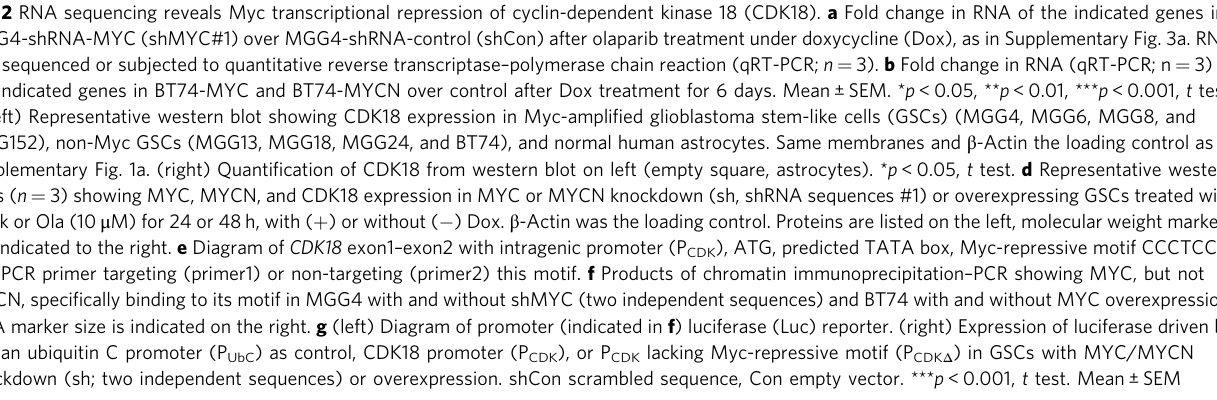
Fig. 2 RNA sequencing reveals Myc transcriptional repression of cyclin-dependent kinase 18 (CDK18). a Fold change in RNA of the indicated genes in MGG4-shRNA-MYC (shMYC#1) over MGG4-shRNA-control (shCon) after olaparib treatment under doxycycline (Dox), as in Supplementary Fig. 3a. RNA was sequenced or subjected to quantitative reverse transcriptase – polymerase chain reaction (qRT-PCR; n = 3). b Fold change in RNA (qRT-PCR; n = 3) of the indicated genes in BT74-MYC and BT74-MYCN over control after Dox treatment for 6 days. Mean ± SEM. * p < 0.05, ** p < 0.01, *** p < 0.001, t test. c (left) Representative western blot showing CDK18 expression in Myc-ampli fi ed glioblastoma stem-like cells (GSCs) (MGG4, MGG6, MGG8, and MGG152), non-Myc GSCs (MGG13, MGG18, MGG24, and BT74), and normal human astrocytes. Same membranes and β -Actin the loading control as in Supplementary Fig. 1a. (right) Quanti fi cation of CDK18 from western blot on left (empty square, astrocytes). * p < 0.05, t test. d Representative western blots ( n = 3) showing MYC, MYCN, and CDK18 expression in MYC or MYCN knockdown (sh, shRNA sequences #1) or overexpressing GSCs treated with mock or Ola (10 μ M) for 24 or 48 h, with ( + ) or without ( − ) Dox. β -Actin was the loading control. Proteins are listed on the left, molecular weight markers are indicated to the right. e Diagram of CDK18 exon1 – exon2 with intragenic promoter (P CDK ), ATG, predicted TATA box, Myc-repressive motif CCCTCCC, and PCR primer targeting (primer1) or non-targeting (primer2) this motif. f Products of chromatin immunoprecipitation – PCR showing MYC, but not MYCN, speci fi cally binding to its motif in MGG4 with and without shMYC (two independent sequences) and BT74 with and without MYC overexpression. DNA marker size is indicated on the right. g (left) Diagram of promoter (indicated in f ) luciferase (Luc) reporter. (right) Expression of luciferase driven